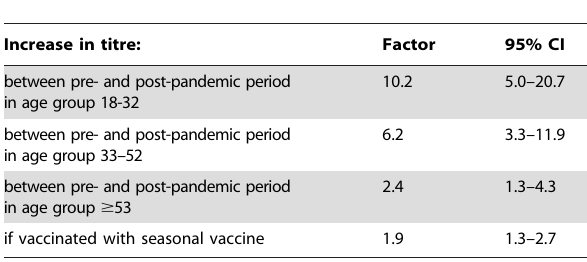
Table 2. Investigated effects of age group, sampling period and vaccination on titre using the final Tobit regression